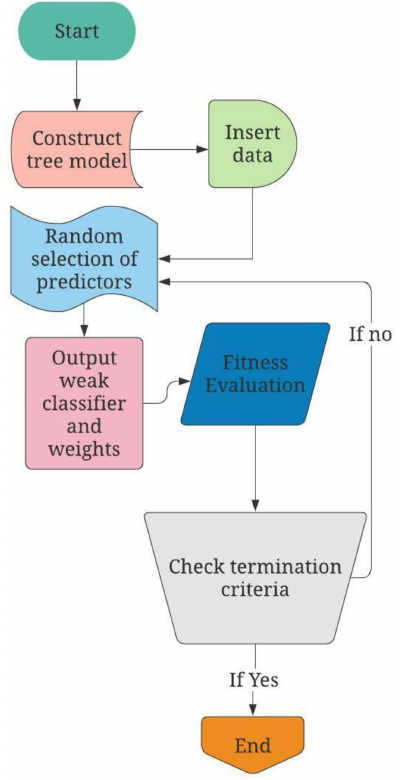
Figure 5. Methodology flowchart for AdaBoost